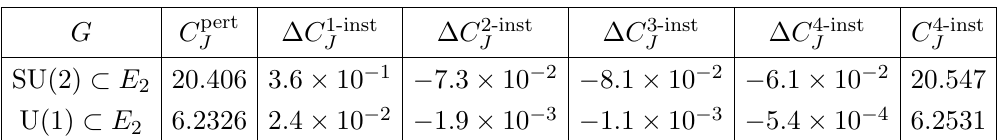
Table 4. The contributions to the values of the (cid:13)avor central charge C G in the rank-one Seiberg exceptional theories and the Morrison-Seiberg e E 1 theory, computed using the fundamental hypermultiplet masses and the instanton particle